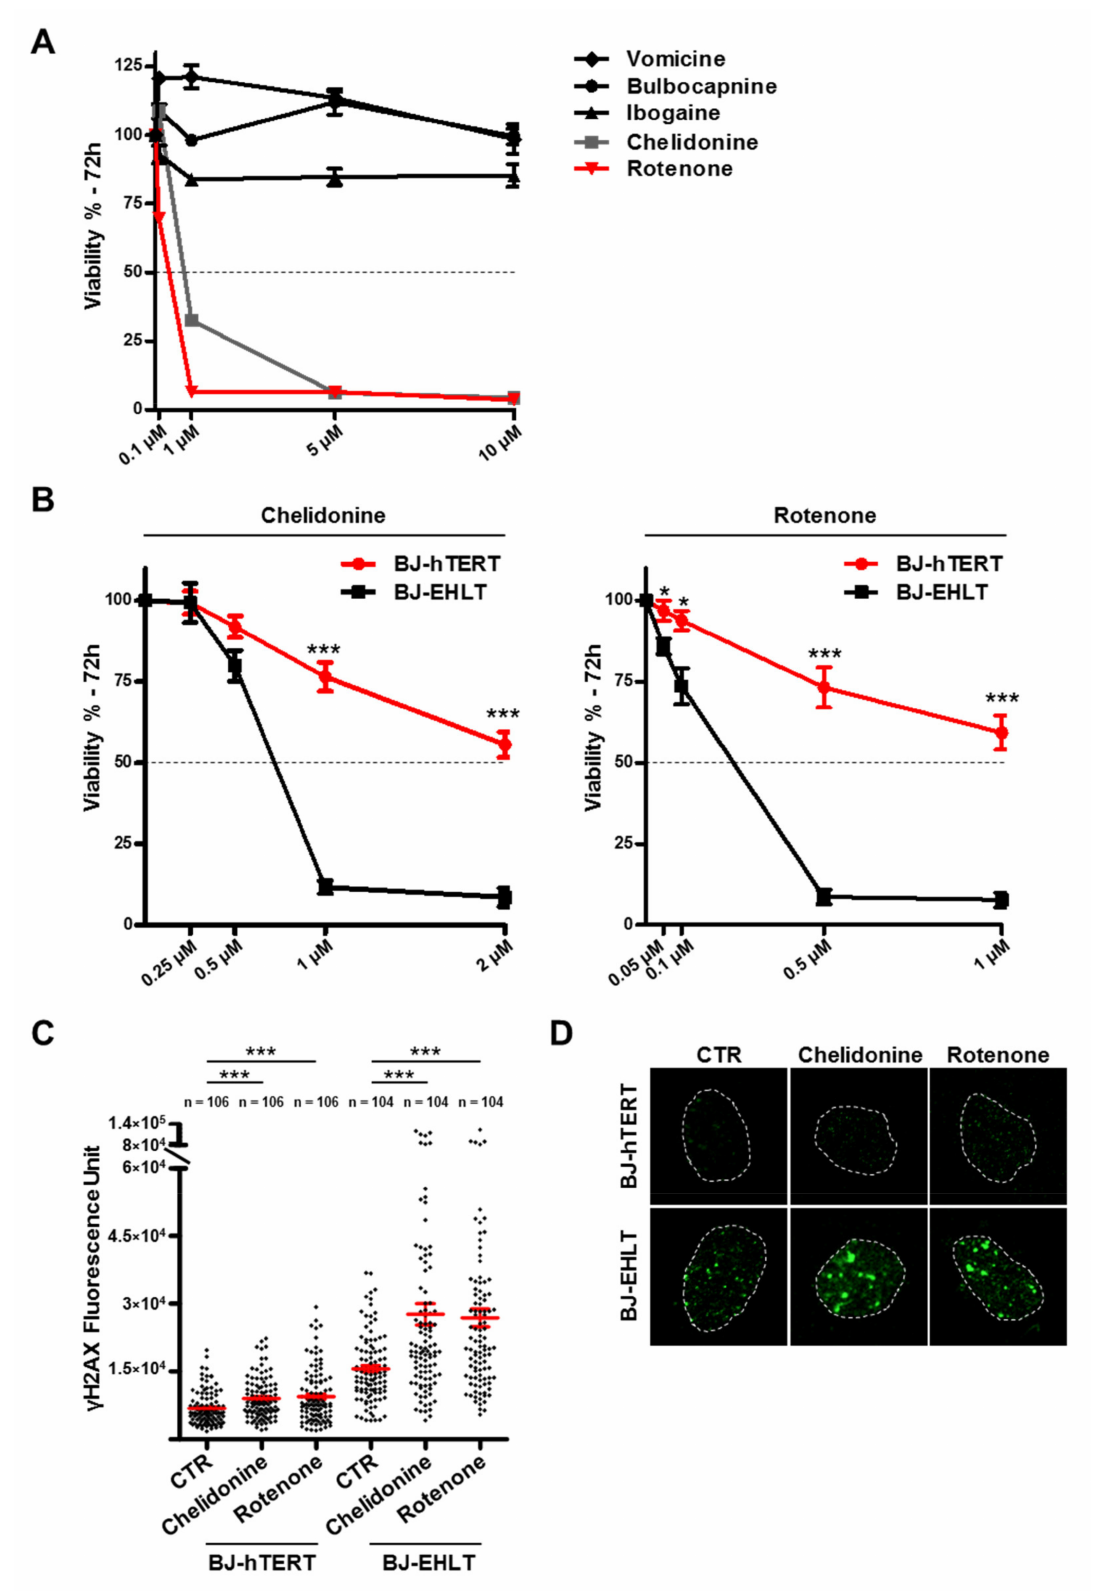
Figure 6. Chelidonine and Rotenone exhibit potential and selective anti-tumor activity. Data of viability and immunofluo- rescence assays. ( A ) Viability screening of candidate molecules. ( B ) Selective activity of Chelidonine and Rotenone against transformed fibroblast BJ-EHLT. ( C ) Quantitative analysis of fluorescence intensity of γ H2AX signal in BJ-hTERT and BJ-EHLT. ( D ) Representative images of γ H2AX fluorescent signal. ns, p > 0.05; *, p < 0.05; ***, p <